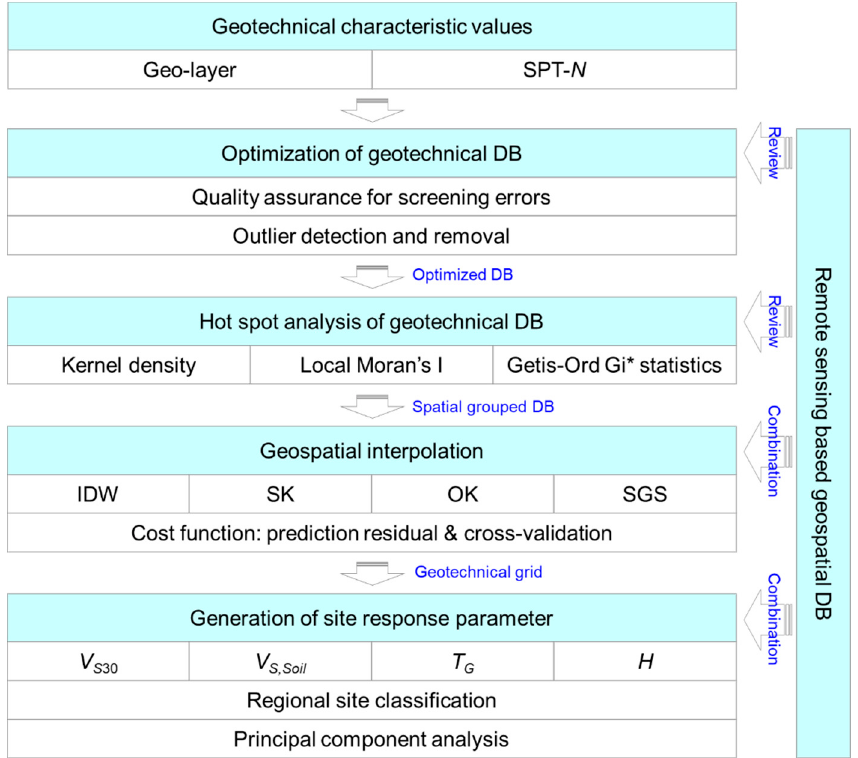
Figure 2. Schematic showing the geospatial characterization procedures for regional seismic site classification. The abbreviation in geospatial interpolation procedure: IDW (inverse distance weighting); SK (simple kriging); OK (ordinary kriging); EBK (empirical Bayesian kriging). The abbreviation in site response parameters: V S 30 (average shear wave velocity up to 30 m below ground); V S,Soil (average shear wave velocity of the overlying soil); T G (natural site period); H (bedrock depth).